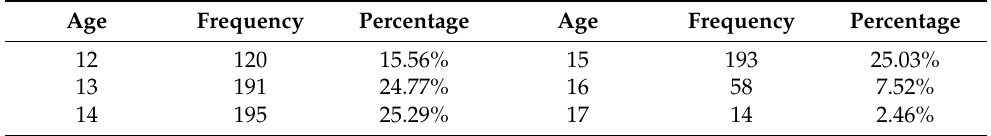
Table 1. Distribution of the sample by age ( N =